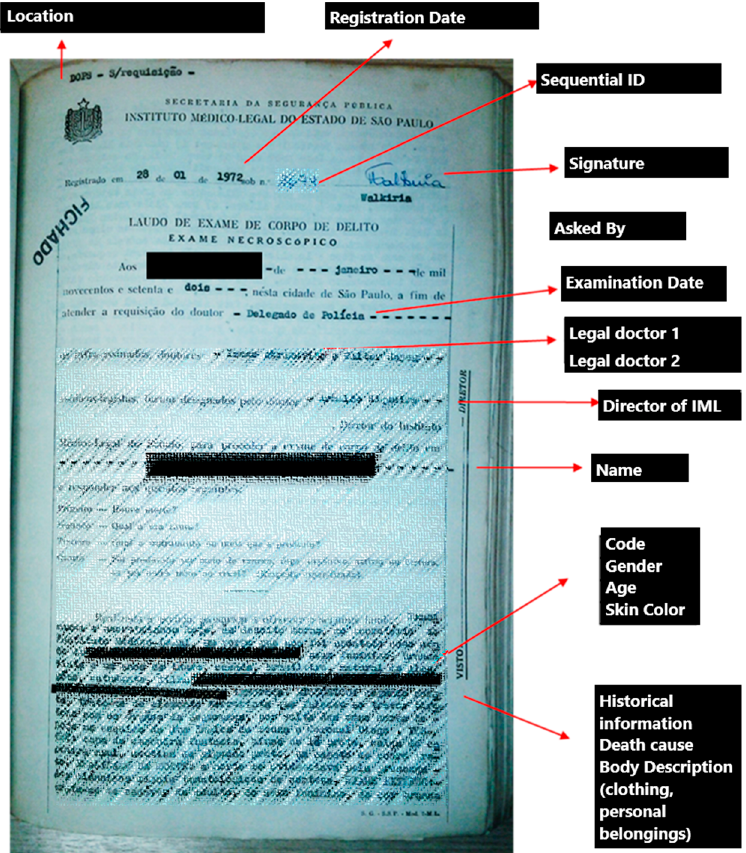
Figure 1. Sample of a forensic report (blurred to protect personal details of a missing person) in the “Disappearances in São Paulo” corpus.